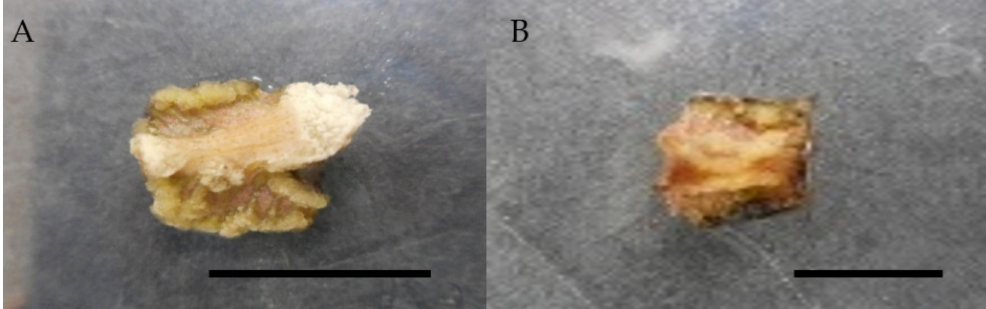
Figure 4. Callus induction of Labisia pumila var. alata on MS medium with the combination of picloram and cytokinins after 4 weeks of culture. ( A ) 1.0 mg/L picloram + 0.5 mg/L kinetin and ( B ) 1.0 mg/L picloram + 0.5 mg/L BAP. Horizontal bar = 1 cm.